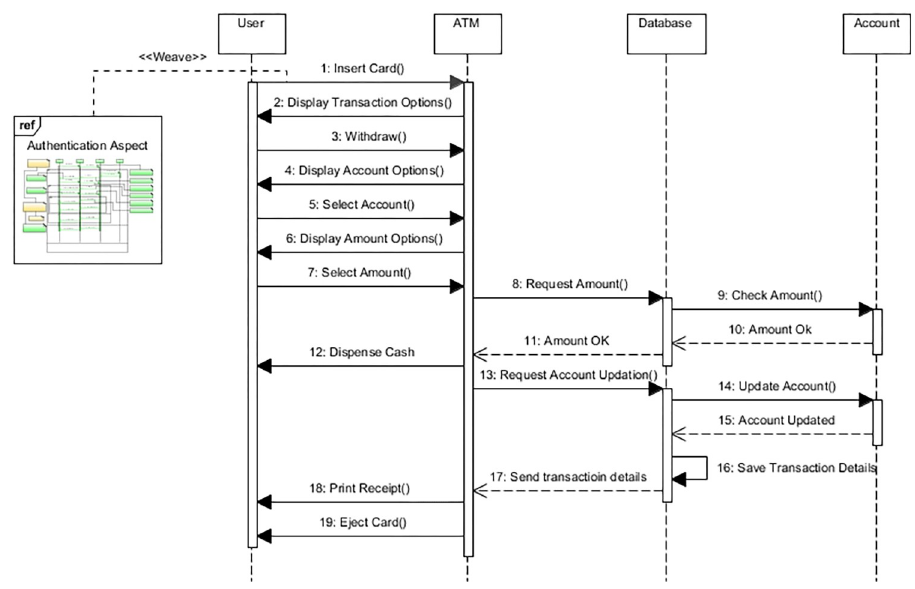
Fig 11. Weaving process.